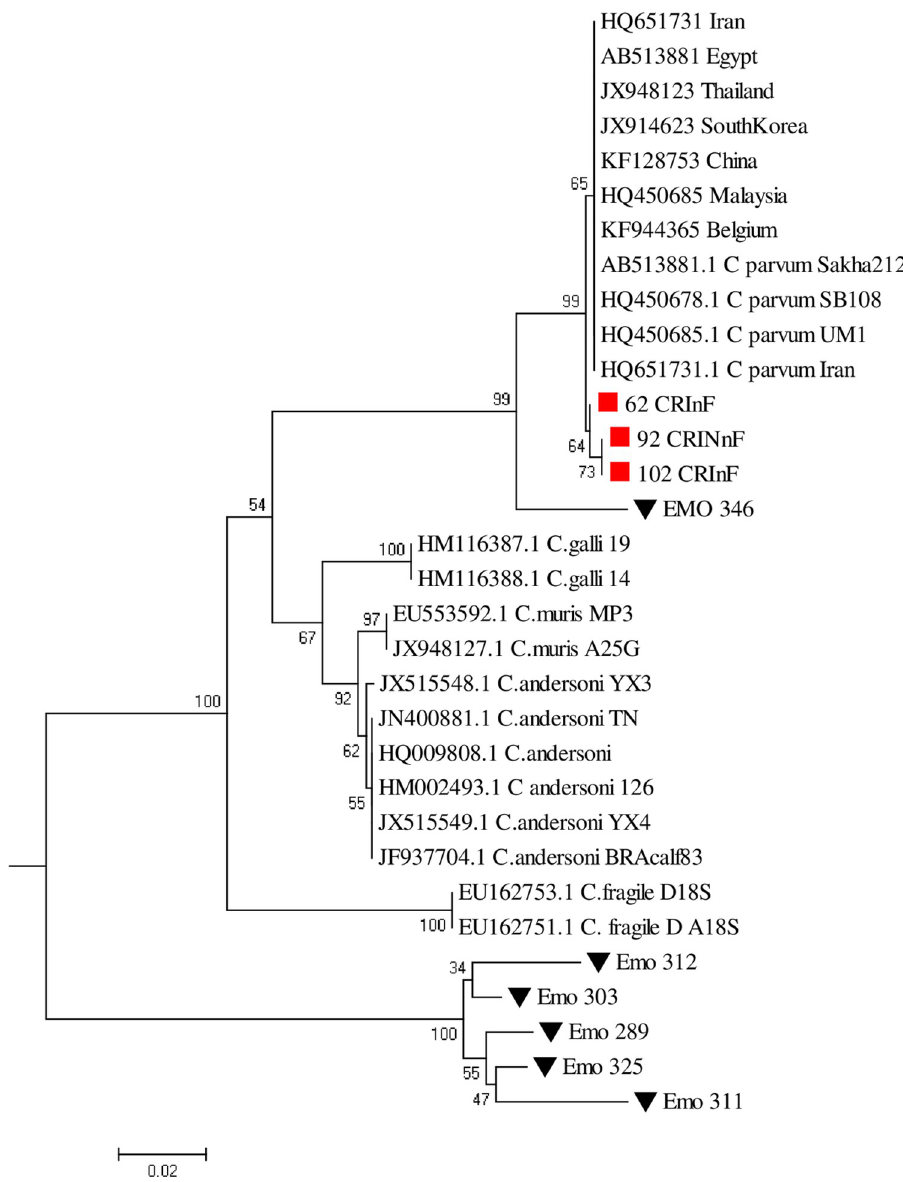
Fig 4. Molecular phylogenetic analysis by maximum likelihood method. The tree with the highest log likelihood (-1334.4013) is shown. The percentage of trees in which the associated taxa clustered together is displayed next to the branches. Red square Sequences obtained from this study. Black triangle Sequences obtained from a study in Accra, Ghana (Anim-Baidoo [55]).